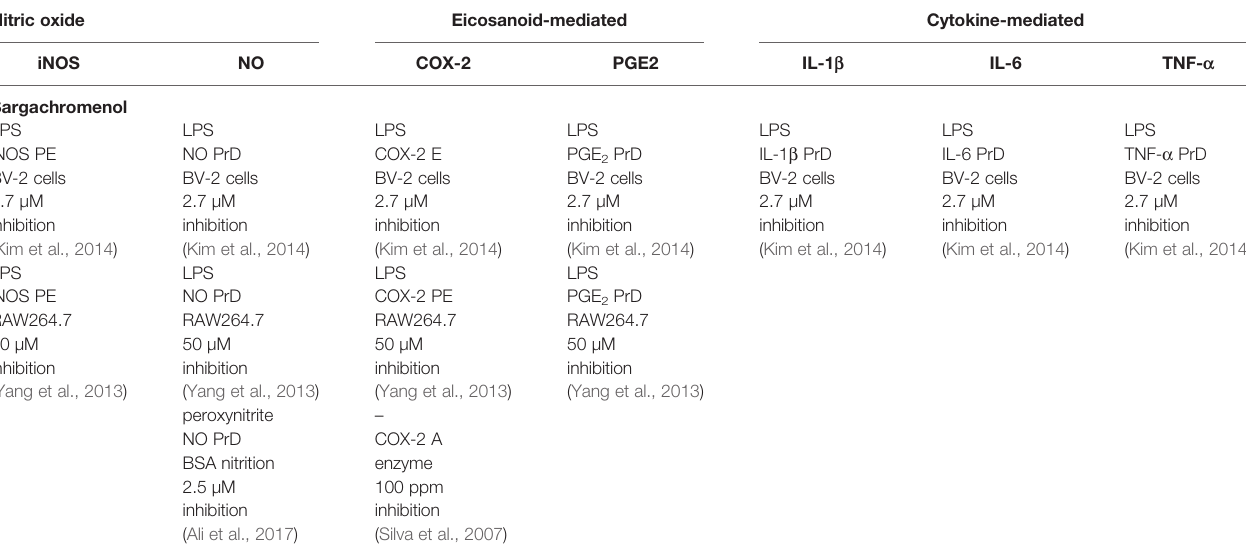
TABLE 2 | Overview on the biological activities of chromenols linked to in fl ammation. Nitric